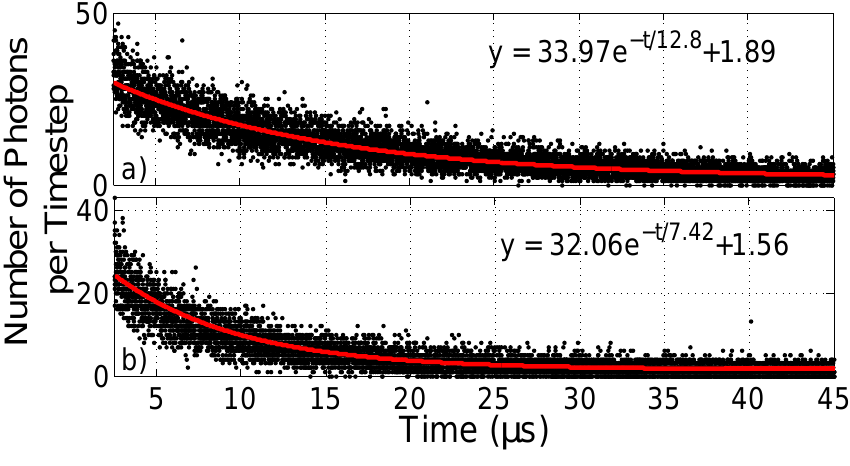
Fig. 3. Timestep in y-axis label corresponds to temporal resolution of Alazar data acquisition card (5.55 ns). Examples of decays for 5min integration for glyoxal ( (a) , 290pptv) and methylglyoxal ( (b) , 5400pptv) taken with the Ti:Sapphire laser with lines of best fit to Eq. (3).